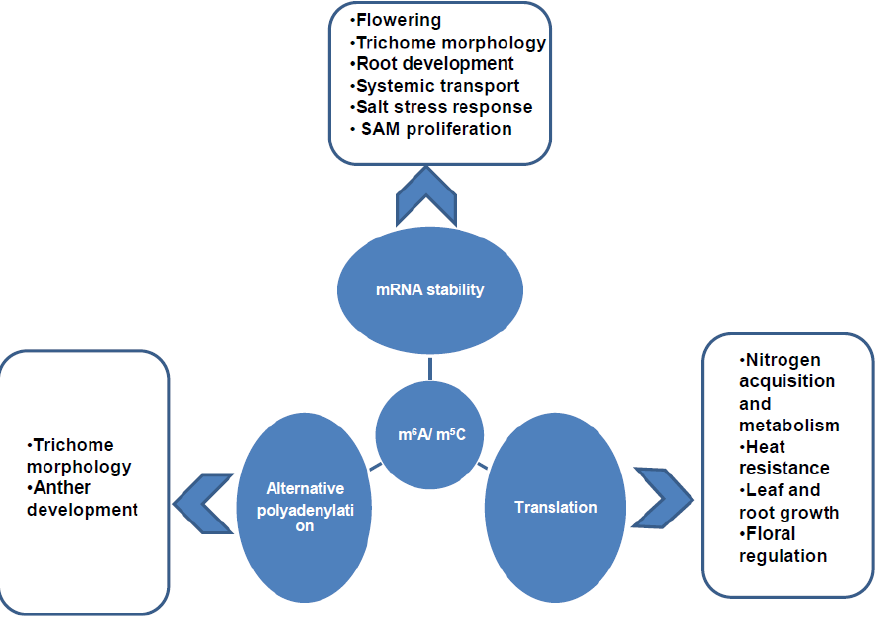
Figure 3. Molecular and physiological regulation by m 6 A and m 5 C; m 6 A and m 5 C modifications regulate various molecular processes including mRNA stability, translation and alternative polyadenylation that affect plant growth and development processes such as anther development, trichome morphology, flowering, SAM proliferation, leaf growth, root growth, and stress responses.